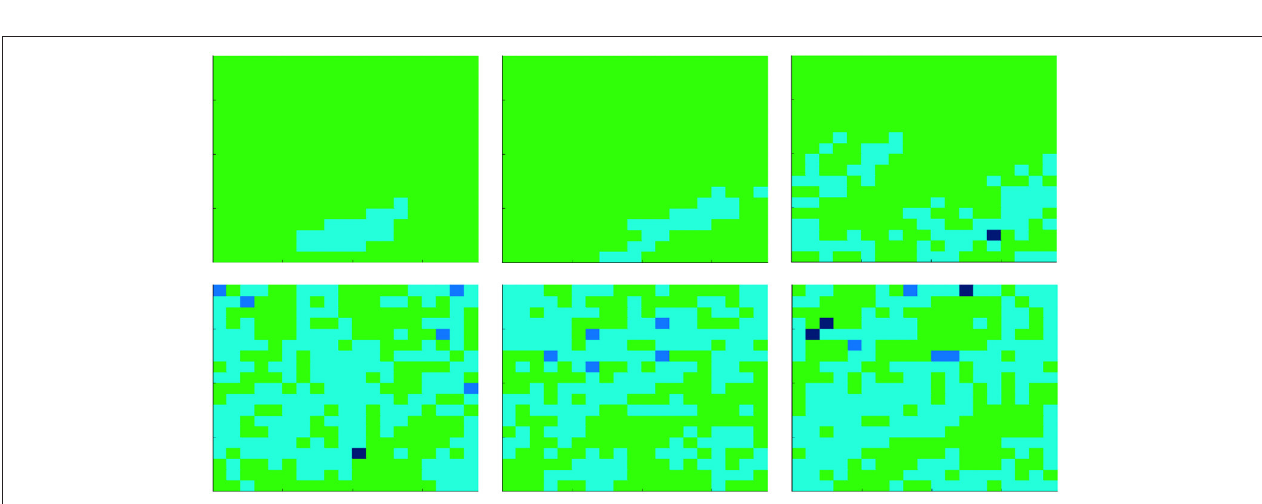
FIGURE 2 | Evolution of the agent population, composed of N = 400 cells, with a constant temperature T = 35. At the beginning, the amount of parasites corresponds to the 5 % of cells. Colors represent the state of cells: those green are healthy (i.e., not infected by parasites), while those cyan, blue, and black are infected. The darkness of infected cells indicates the parasites’ payoff, i.e., the darkest the richest (i.e., the strongest vs. cell attacks). Each subplot refers to a different time step, starting from t = 0 (i.e., the first one) up to t = 175,000 (from left to right, and from the upper part to the lower part). All plots refer to a single realization of a simulation.